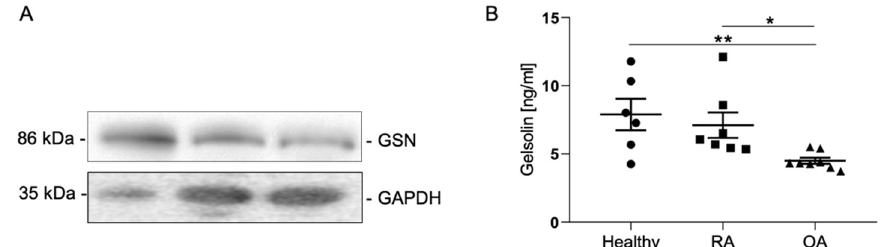
Figure 6. Detection and quantification of gelsolin in synovial fluid from healthy subjects and RA and OA patients. ( A ) Western blot analysis of synovial fluid (SF) from a healthy control subject and patients with RA and OA. ( B ) Gelsolin ELISA of SF samples from healthy subjects, RA and OA patients, t -test, * p < 0.5; ** p < 0.01.